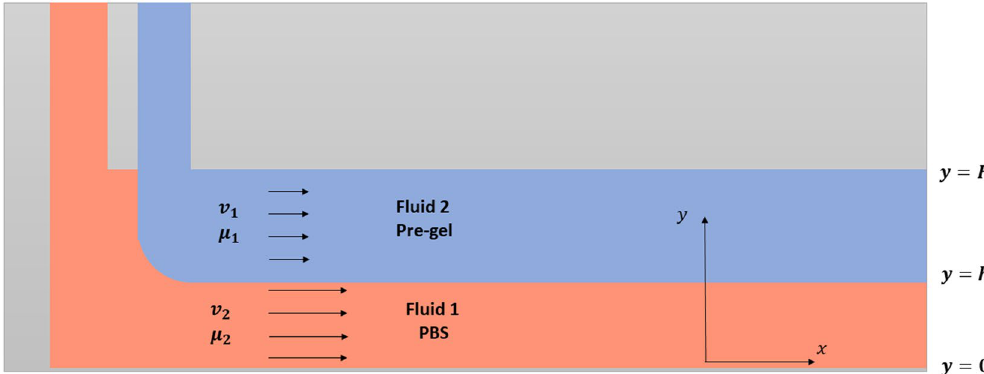
Figure 3. Scheme of the parallel flow model. Fluid 1, flowing on top, is the sacrificial fluid, PBS. Fluid 2 is the pre-gel solution containing the fibroblasts. The value of h changes as a function of the flows.